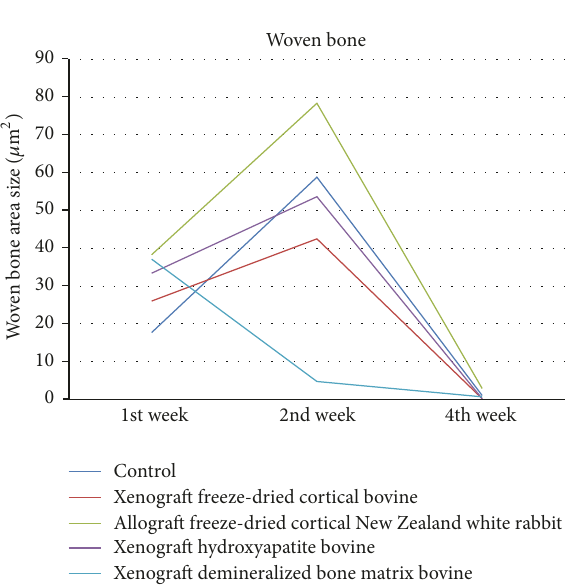
Figure 6: Evaluation of woven bone area size.